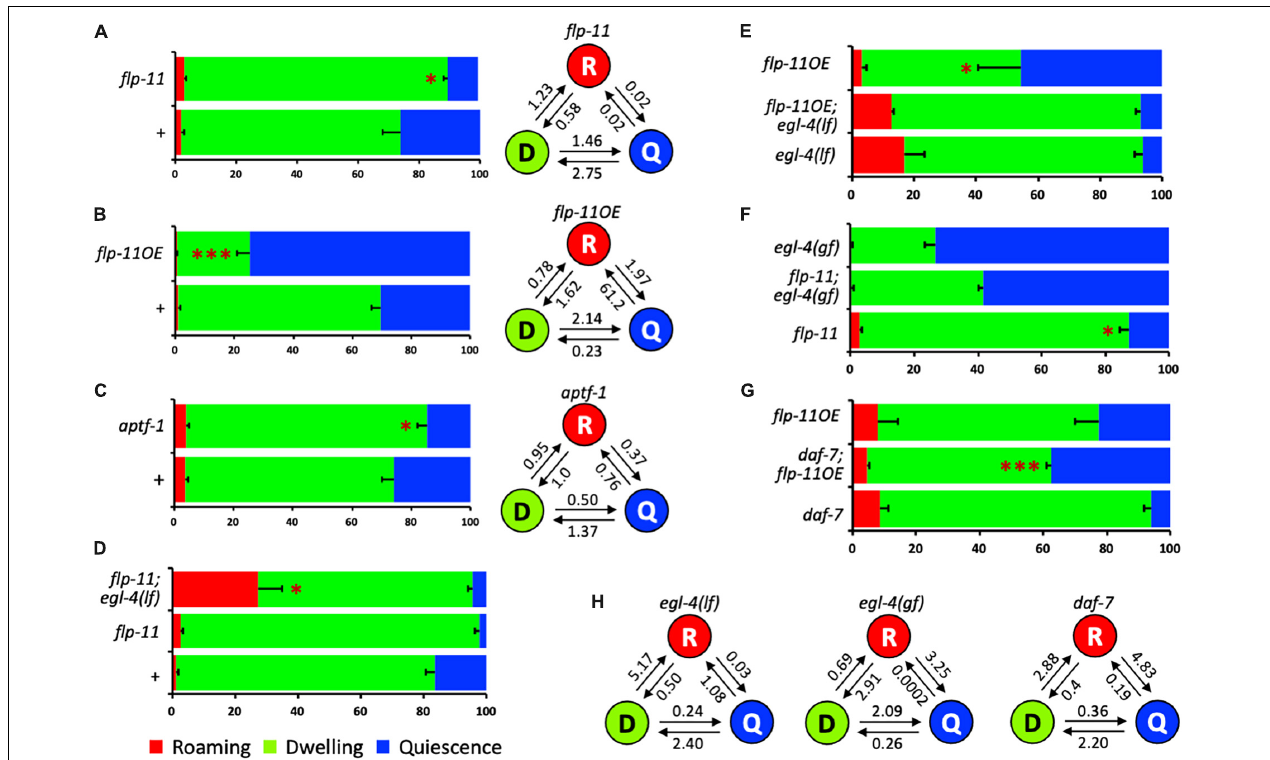
FIGURE 2 | The potential mechanisms of flp-11 in satiety quiescence. (A) flp-11 mutants show reduced satiety quiescence, confirming the RNAi result. The percent time and the normalized transition rates among the three states are shown. (B) An overexpression line of flp-11 shows enhanced satiety quiescence. The data is a representative of two overexpression lines. The percent time and the normalized transition rates among the three states are shown. (C) aptf-1 , a transcription factor acting in RIS that promotes other types of sleep behavior in C. elegans , is also required for satiety quiescence. The percent time and the normalized transition rates among the three states are shown. (D) Both flp-11 and flp-11 ; egl-4 loss of function mutants are defective in satiety quiescence [for comparison to egl-4 single mutant, see (E) ]. Considering the roaming behavior of the flp-11 ; egl-4 mutants shown in the red bar, egl-4 could be epistatic to flp-11 . (E) Overexpression of flp-11 does not suppress the defect in the egl-4 loss of function mutants. (F) A gain-of-function allele of egl-4 (gf) rescued flp-11 loss of function, suggesting that egl-4 could act downstream of flp-11 . (G) flp-11 overexpression suppresses the defect in quiescence of daf-7 mutant. (H) The transition rates of egl-4(if) , egl-4(gf) , and daf-7 mutants. ( ∗ p < 0.05, ∗∗∗ p < 0.001 by Student’s t -test. The error bars indicate SEM).